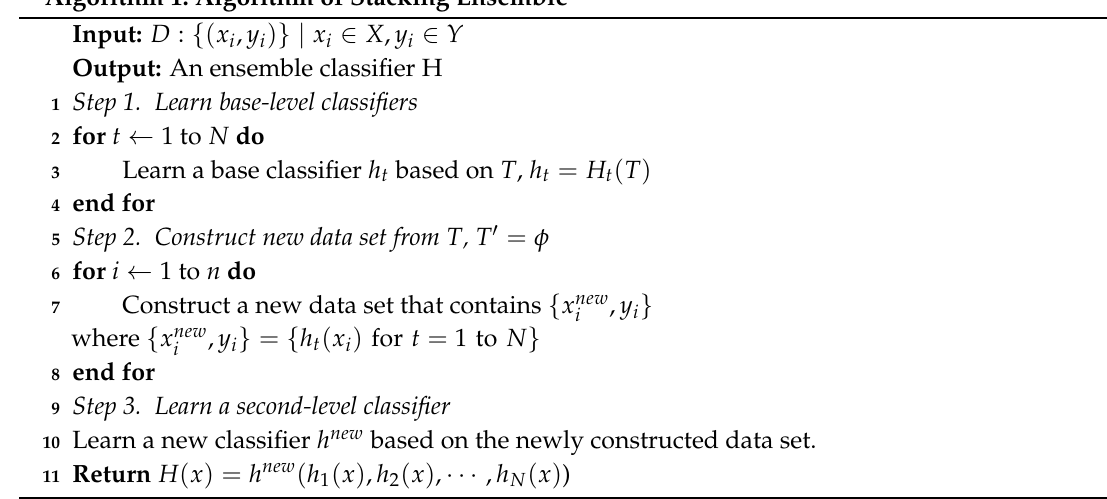
Algorithm 1: Algorithm of Stacking Ensemble